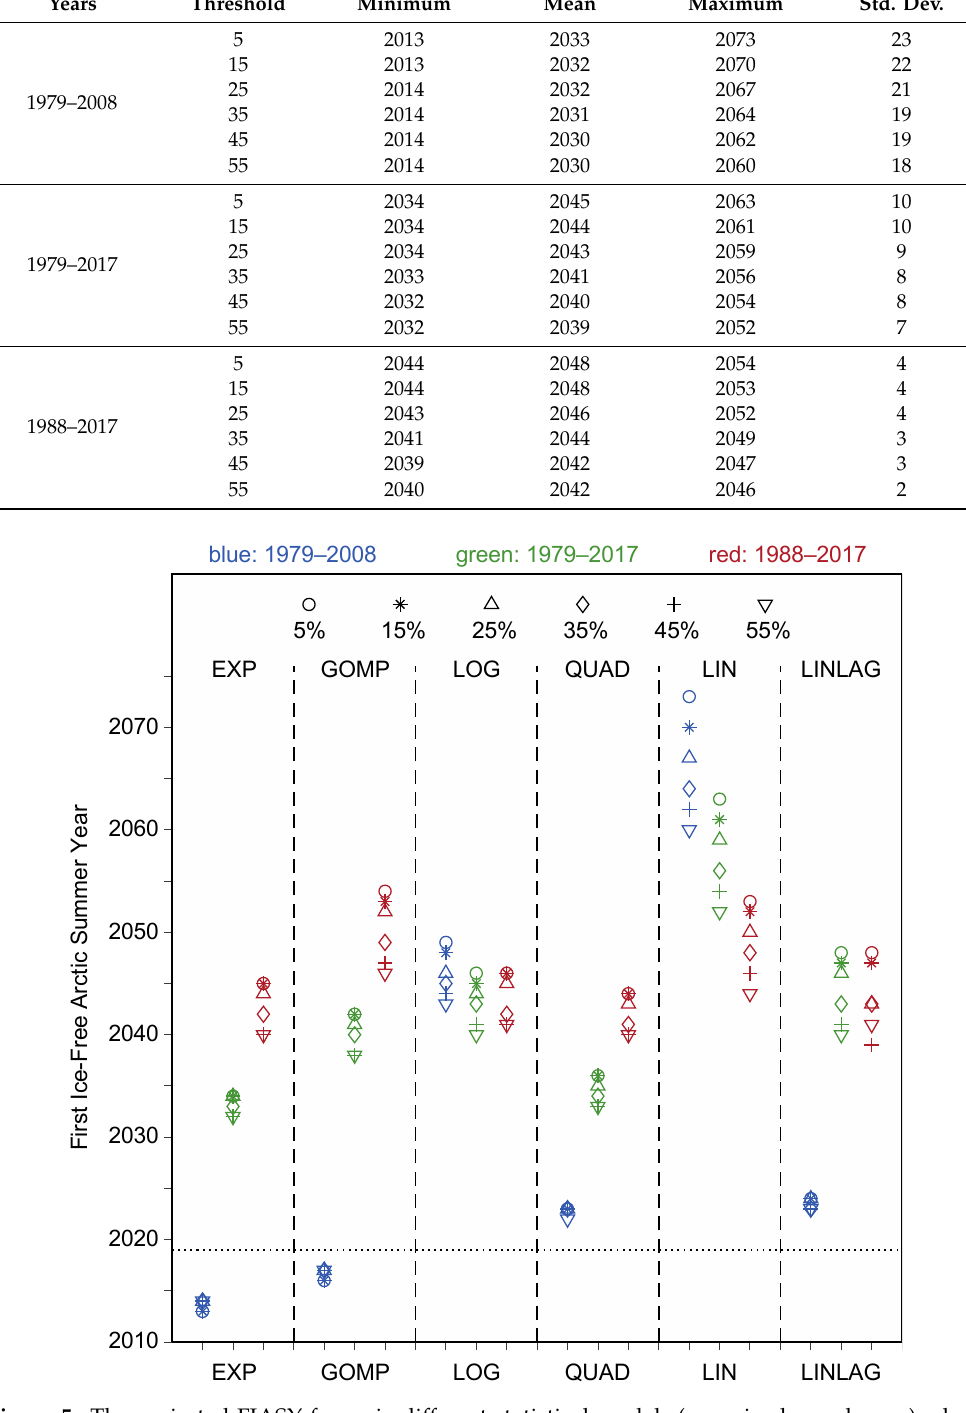
Figure 5. The projected FIASY from six different statistical models (organized as columns) where color depicts the temporal domain of model calibration, and symbol indicates the threshold choice. The dashed line indicates the present year, so it may be interpreted that predictions under this line are infeasible.